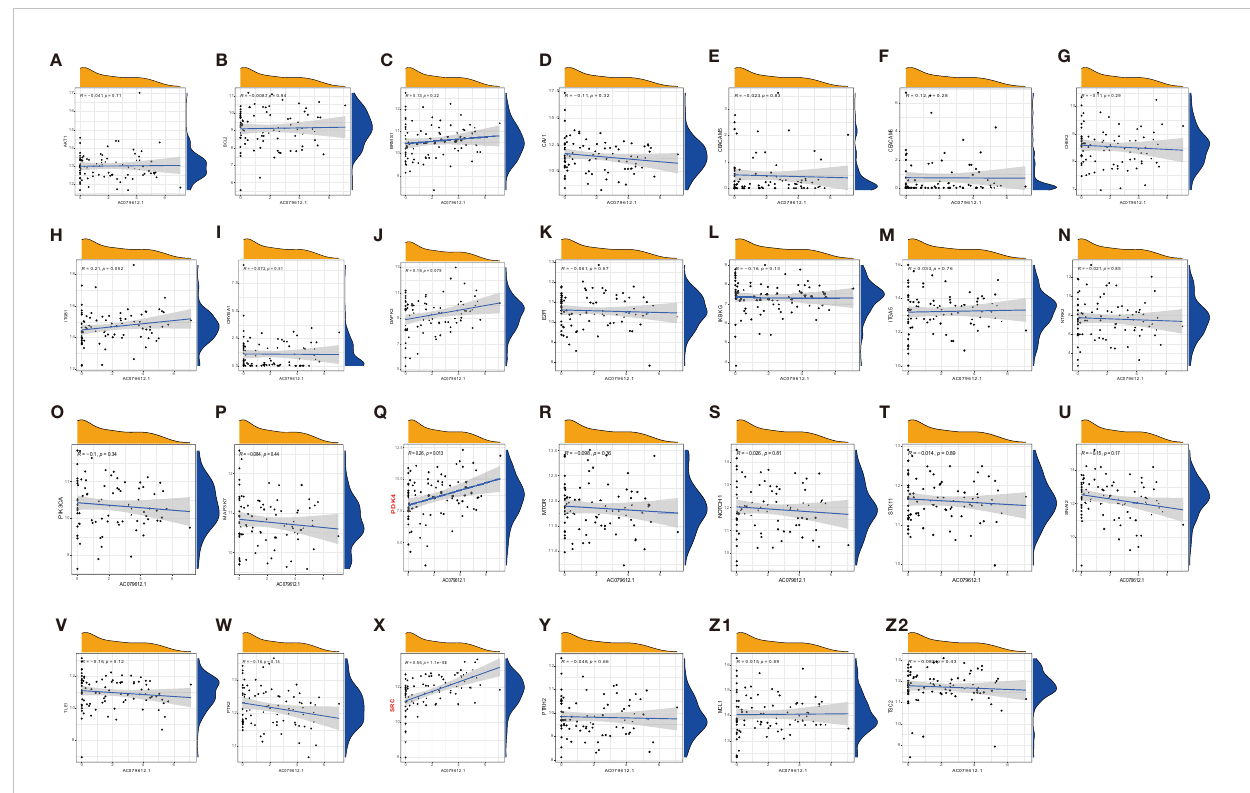
FIGURE 11 Pearson correlation analysis of AC079612.1 with anoikis-related genes ( A – Z2 : CRYBA1, ITGB1, MAP3K7, NOTCH1, CEACAM6, IKBKG, CAV1, MCL1, BRMS1, SNAI2, ITGA5, MTOR, DAPK2, PIK3CA, PTRH2, PDK4, TLE1, TSC2, E2F1, CHEK2, CEACAM5, PTK2, AKT1, NTRK2, STK11, SRC, and BCL2).